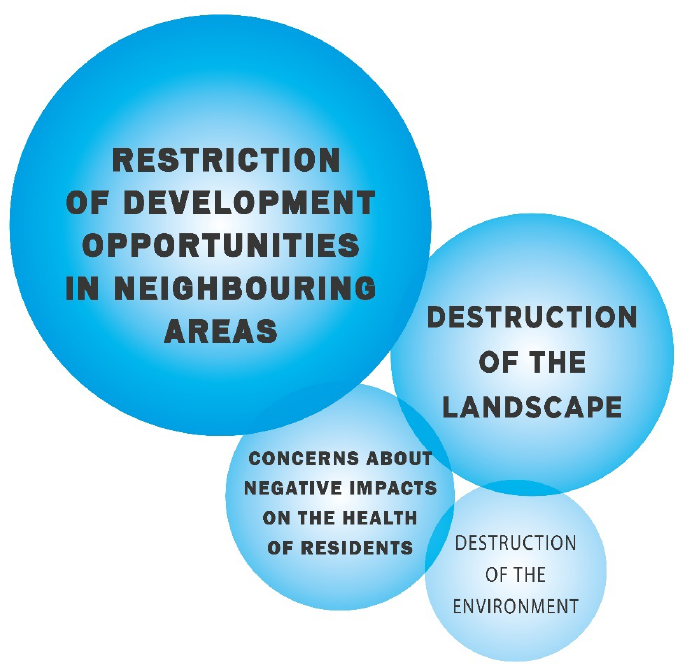
Figure 2. Main reasons for spatial conflicts regarding spatial plans and wind power plants in the studied municipalities. Source: own elaboration.